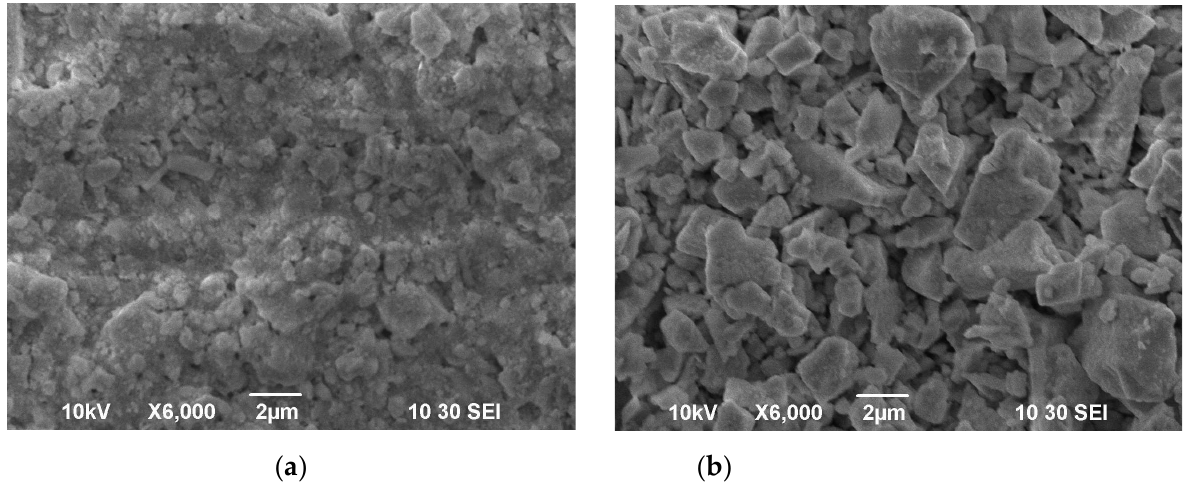
Figure 5. SEM images of the green EPD coatings deposited on the Ni-foil substrate (80 V, 1 min): ( a ) SDC-gn/lec; ( b ) BCS-CuO.